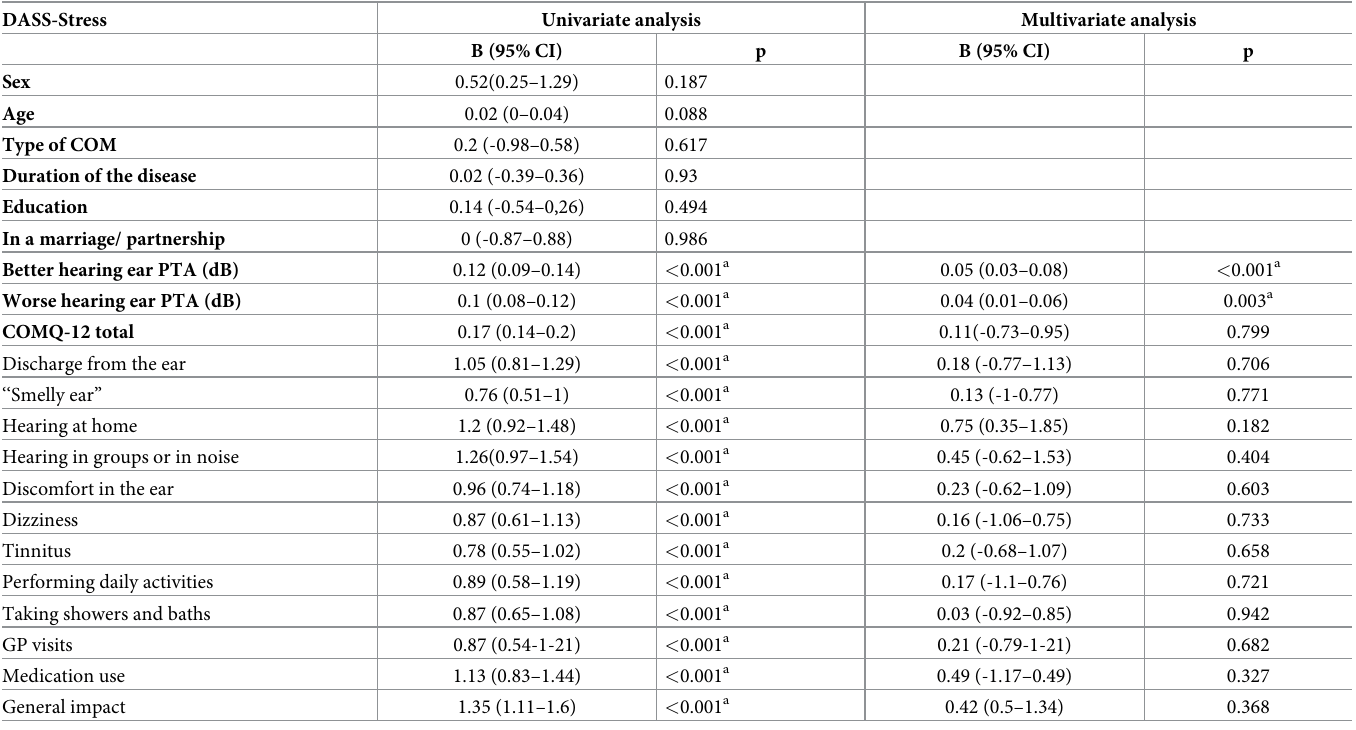
Table 6. Univariate and multivariable logistic regression for DASS-stress